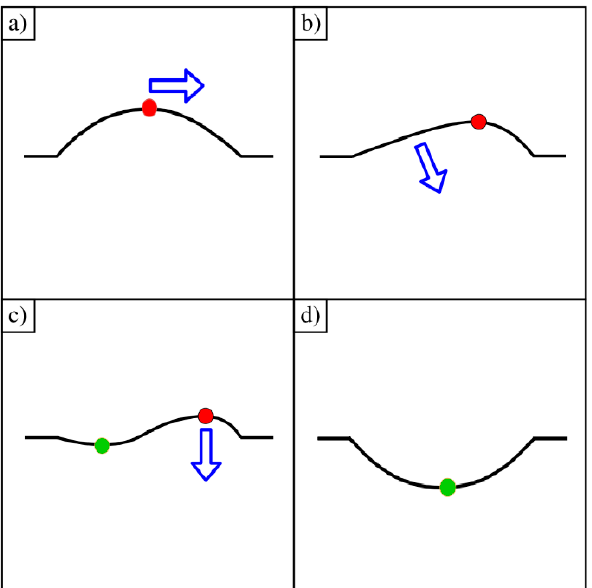
Figure 8. Conceptual illustration of the shape transformation through curvature inversion: ( a ) The maximum of the ripple moves from center to right; ( b ) Curvature is low on the left side. Local atoms are pulled down toward the fixed frame; ( c ) The left side passes through the x–y plane and the ripple forms a sine-like shape; ( d ) The left sub-ripple has pulled the right sub-ripple down. A single ripple is formed below the x-y plane.